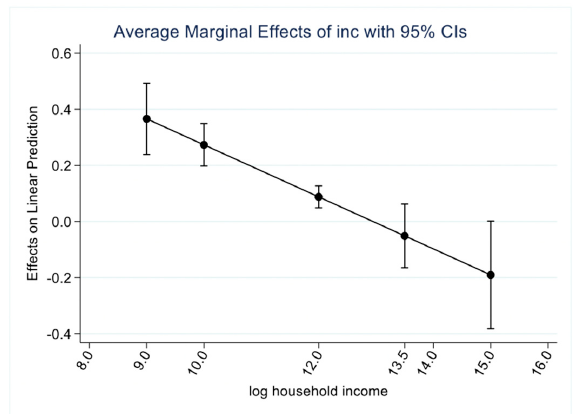
Figure 1. Average marginal effect of income on the household consumption of sugary drinks.